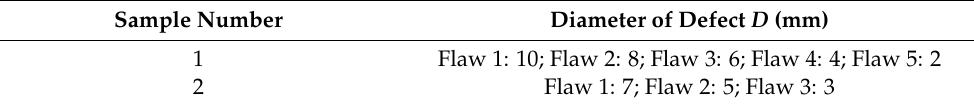
Figure 1. The schematic diagram of the dimension of the sample 1. Table 2. Thickness of ceramic coating and the dimension of the interfacial defects.